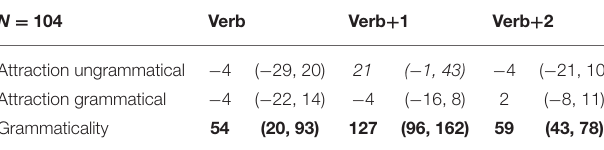
Table 2 | Results of experiment